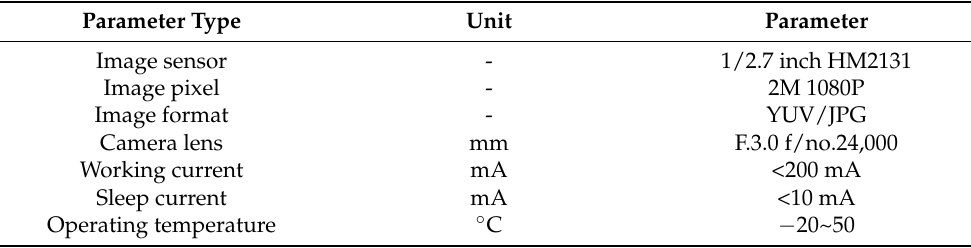
Figure 6. Data acquisition equipment: ( a ) equipment installation diagram; ( b ) data acquisition equipment. Table 1. Camera parameters.